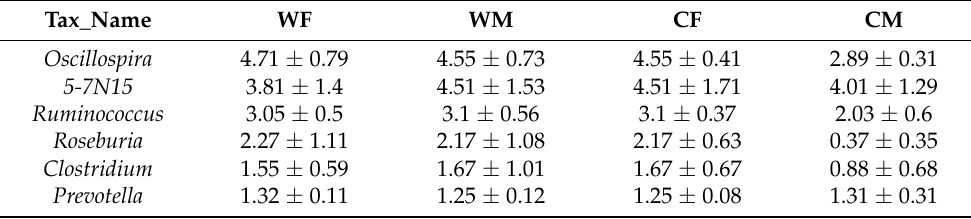
Table 1. Relative abundance > 1% at the genus level for four groups of red deer fecal